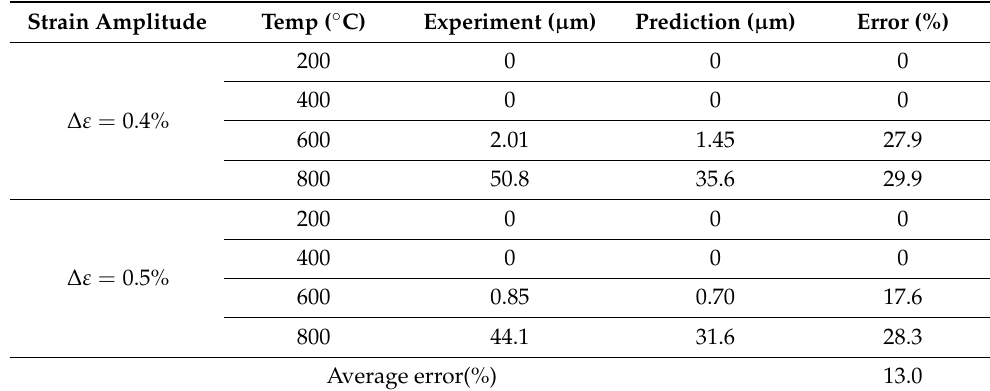
Table 4. Results of penetration length of oxide intrusion obtained from experiments and predictions. Strain